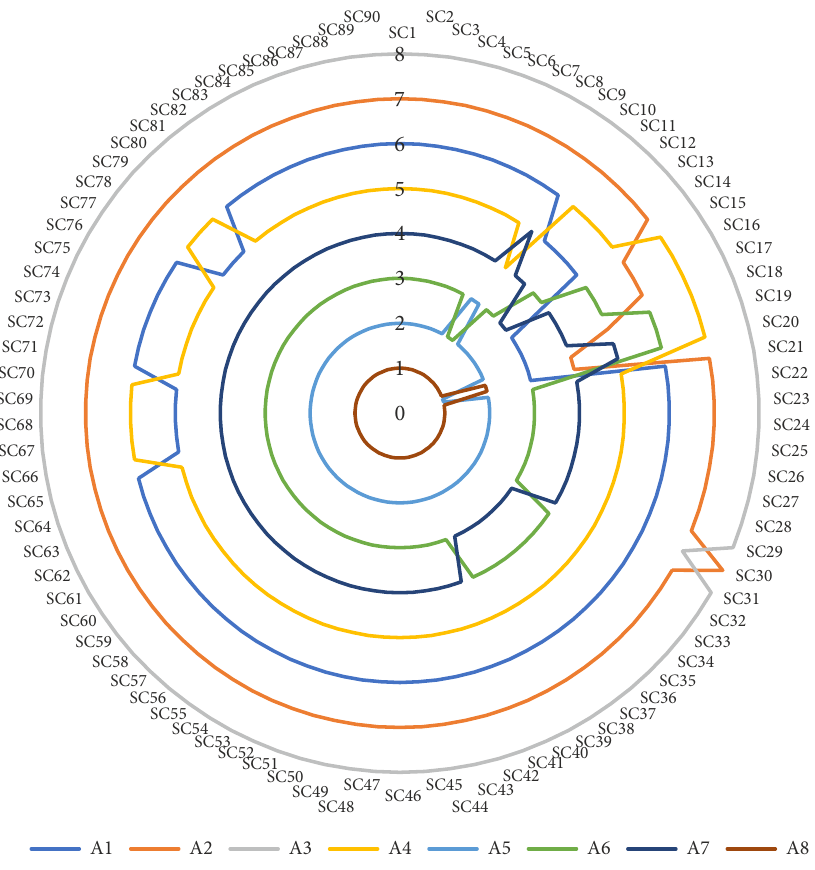
Figure 3. Ranking the alternatives for modified weights of criteria Table 14. The new ranking of the alternatives according to the scenarios Scenario